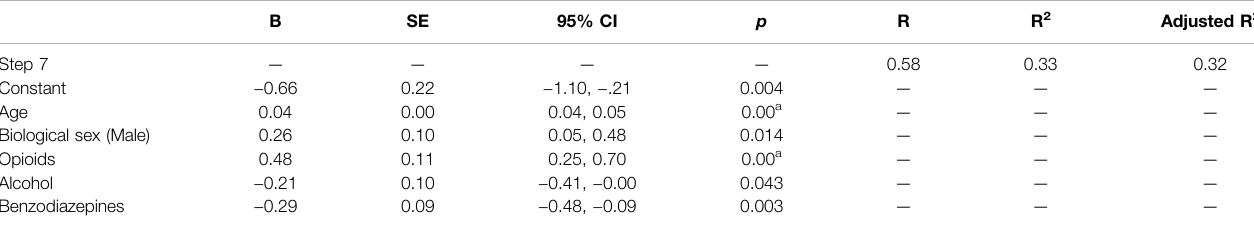
TABLE 4 | ( Continued ) Stepwise multiple regression model with backward procedure predicting total cardiovascular disease (CVD) severity from age, BMI, sex, opioids, alcohol, cannabis, stimulants, benzodiazepines, TCAs, anticonvulsants, and SSRIs in 436 post-mortem